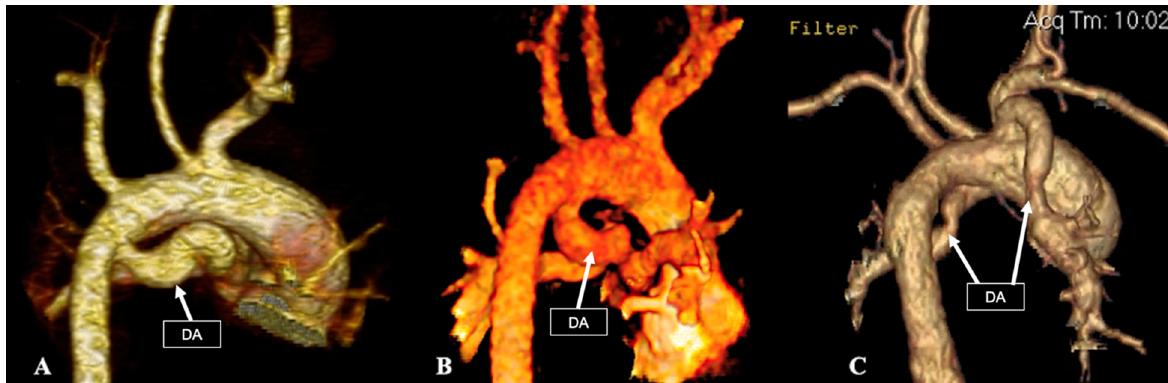
Figure 1. Three-dimensional cardiac computed tomography in different origins of the ductus arteriosus (DA). ( A ) Originated from the proximal descending aorta. ( B ) Originated from the aortic arch. ( C ) Originated from the aortic branches. Pictures, courtesy of Phuoc Duong, MD. Paediatric Cardiologist, Alder Hey Children’s Hospital, Liverpool, The UK.